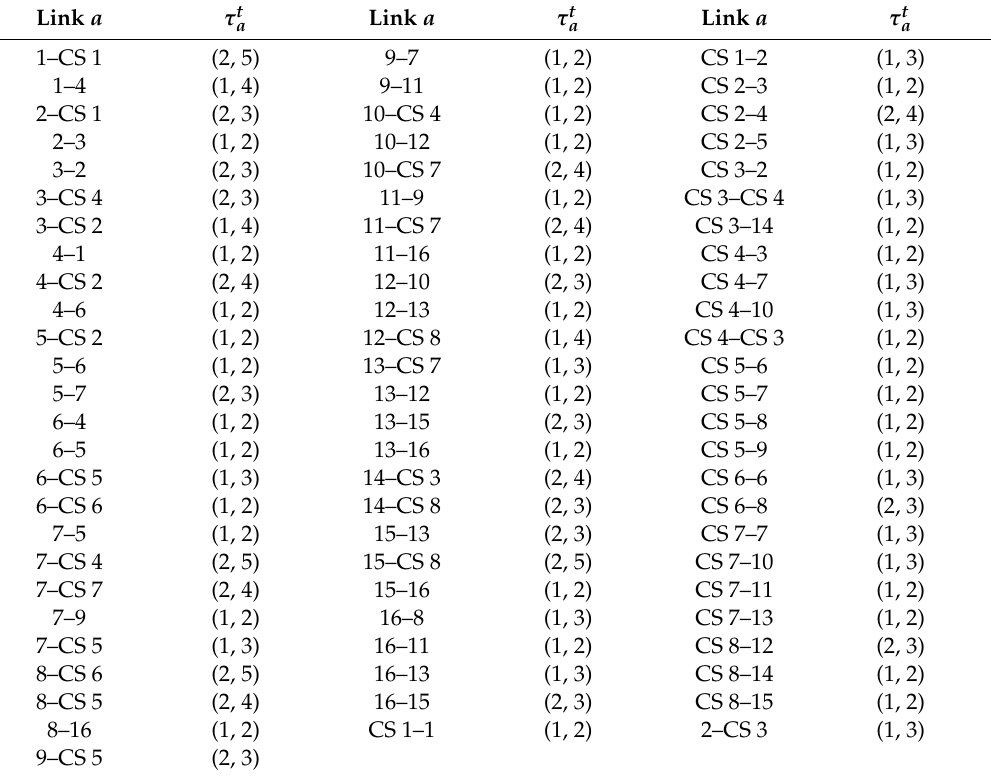
Table A4. Value intervals of driving time τ t a for link a at time slot t .